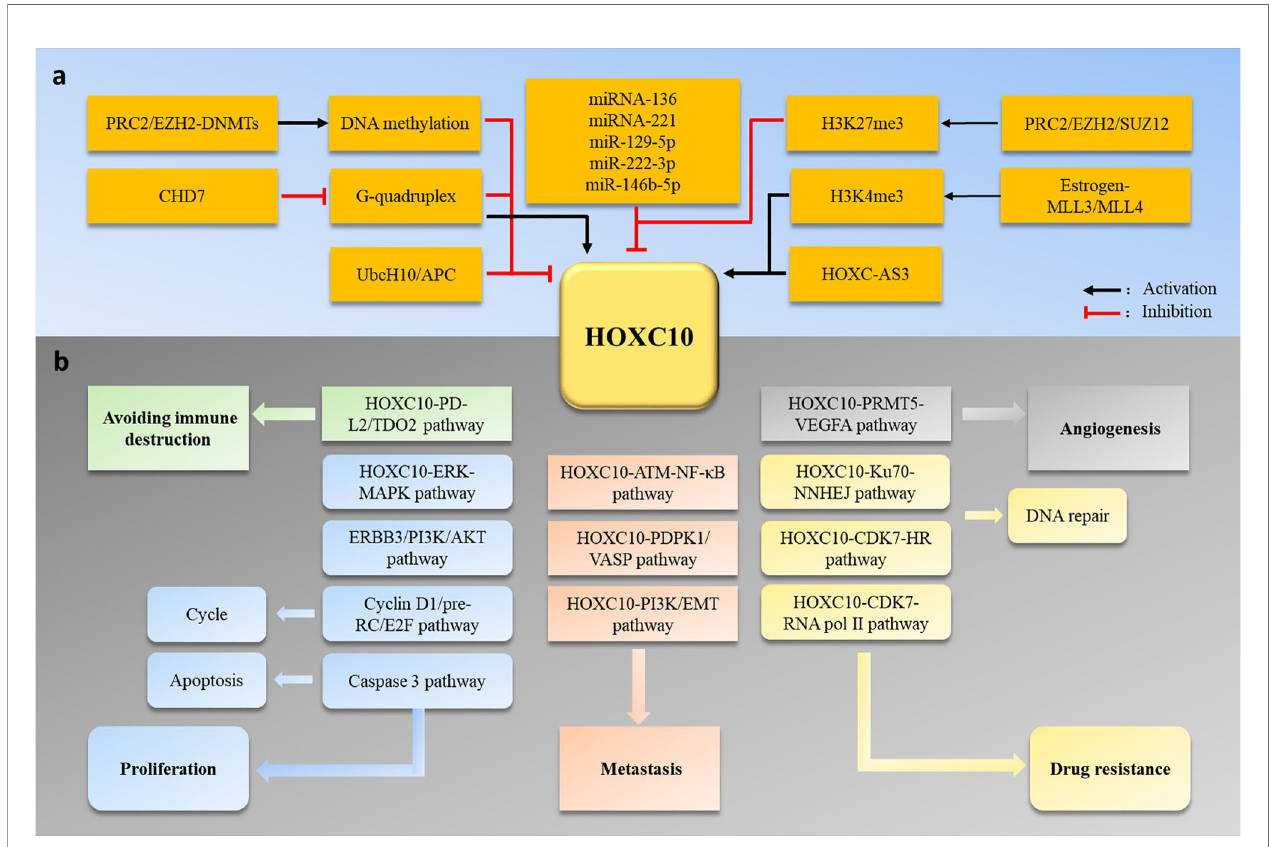
FIGURE 3 | (A) HOXC10 expression is regulated by DNA methylation, histone methylation, miRNA, lncRNA, and the ubiquitin-degradation pathway. (B) Abnormal HOXC10 expression can induce tumor occurrence and development by promoting cell proliferation, metastasis, angiogenesis, drug resistance and avoidance of immune